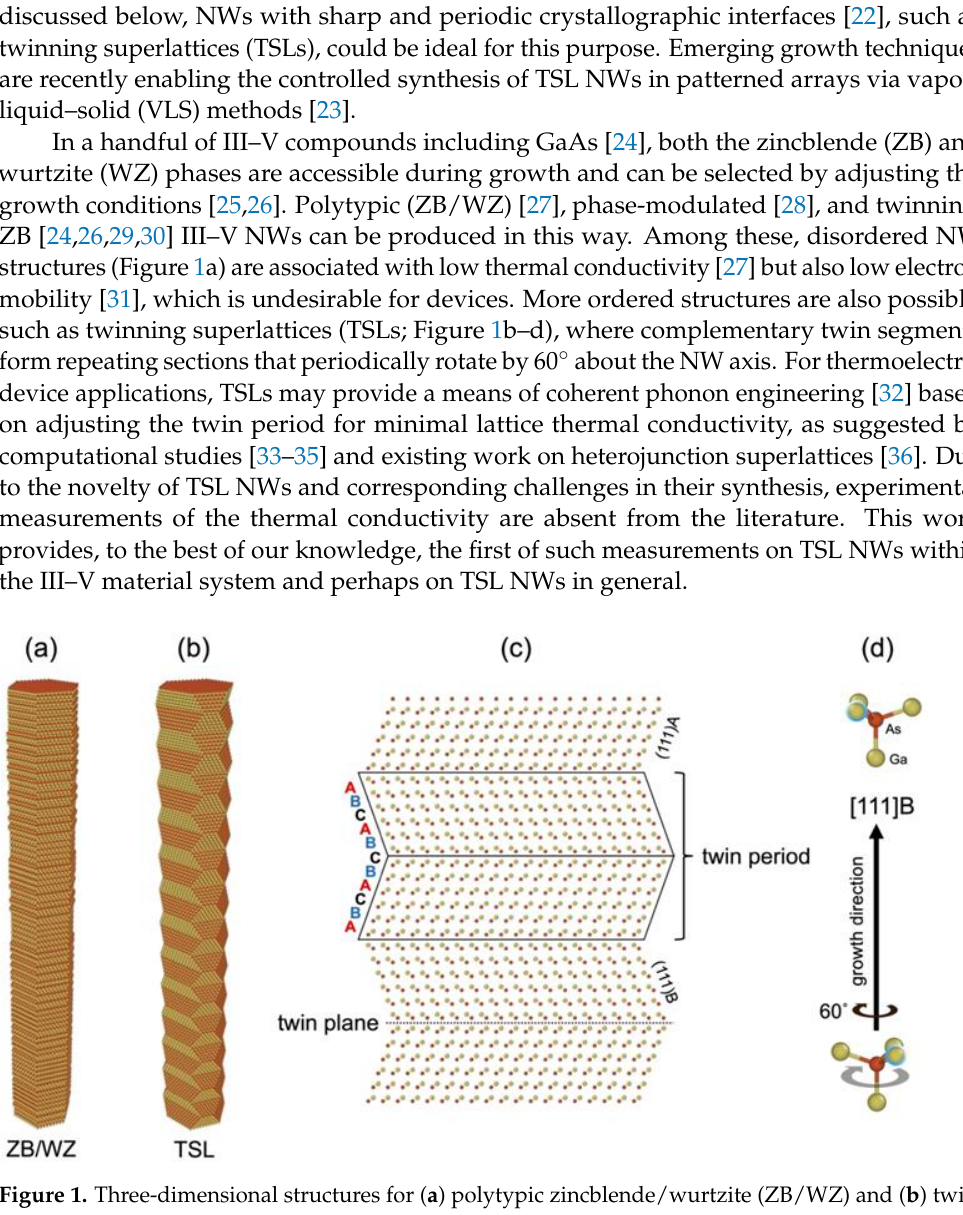
Figure 1. Three-dimensional structures for ( a ) polytypic zincblende/wurtzite (ZB/WZ) and ( b ) twin- ning superlattice (TSL) nanowires, showing [111]A and [111]B surface faceting in the latter. ( c ) Bilayer stacking in the TSL, seen in an orthogonal projection along [112̅ ], exhibiting reversal of the normal ABC stacking sequence across the twin plane. ( d ) Twinning is equivalent to a rotation of the crystal structure about the NW axis by 60°, illustrated by tetrahedral primitives of bulk GaAs. The indicated growth direction applies to the entire figure.